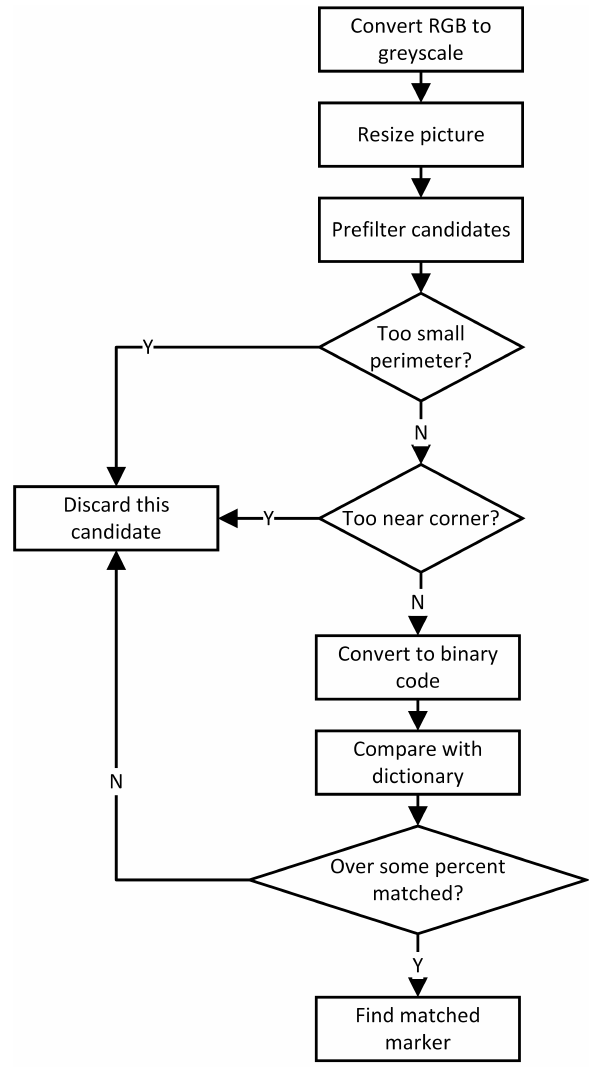
Figure 5. ArPico Image Processing